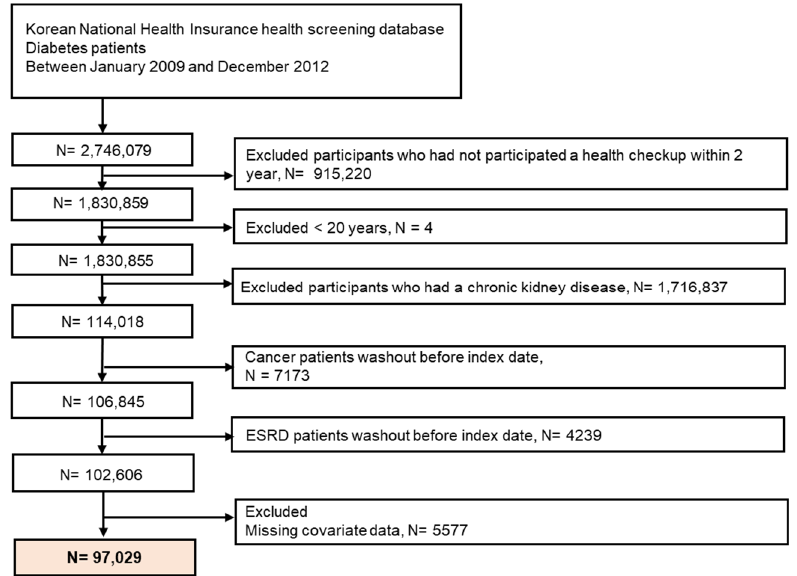
Figure 1. Flowchart of participant enrolment.